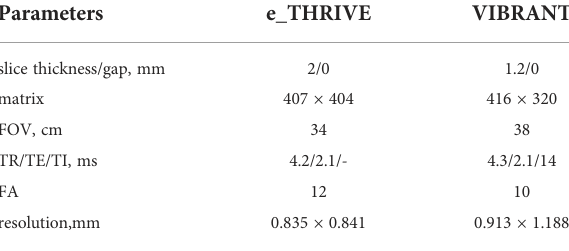
TABLE 1 Acquisition Parameters Used in the Breast DCE-MRI